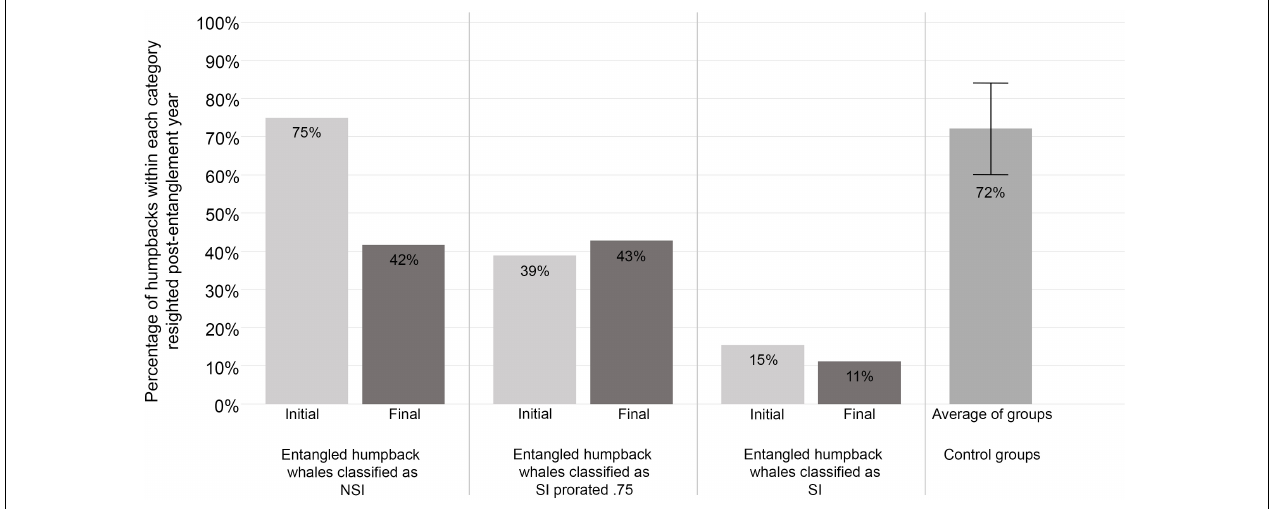
FIGURE 4 | Initial and final serious injury and mortality (SI/M) scores compared to resightings of entangled whales. Ninety-five percent ( n = 35) of the confirmed entangled humpback whale cases used in our resight analysis were assigned initial and final SI/M scores from Southwest Fisheries Science Center. Based on the resighted individuals in our study, the adjustment from initial to final score appeared to provide survival estimates that were less in line with our resightings of individuals classified as having a non-serious injury (NSI) and a serious injury prorated by 75% (SI prorated 0.75). However, the percentage of individuals